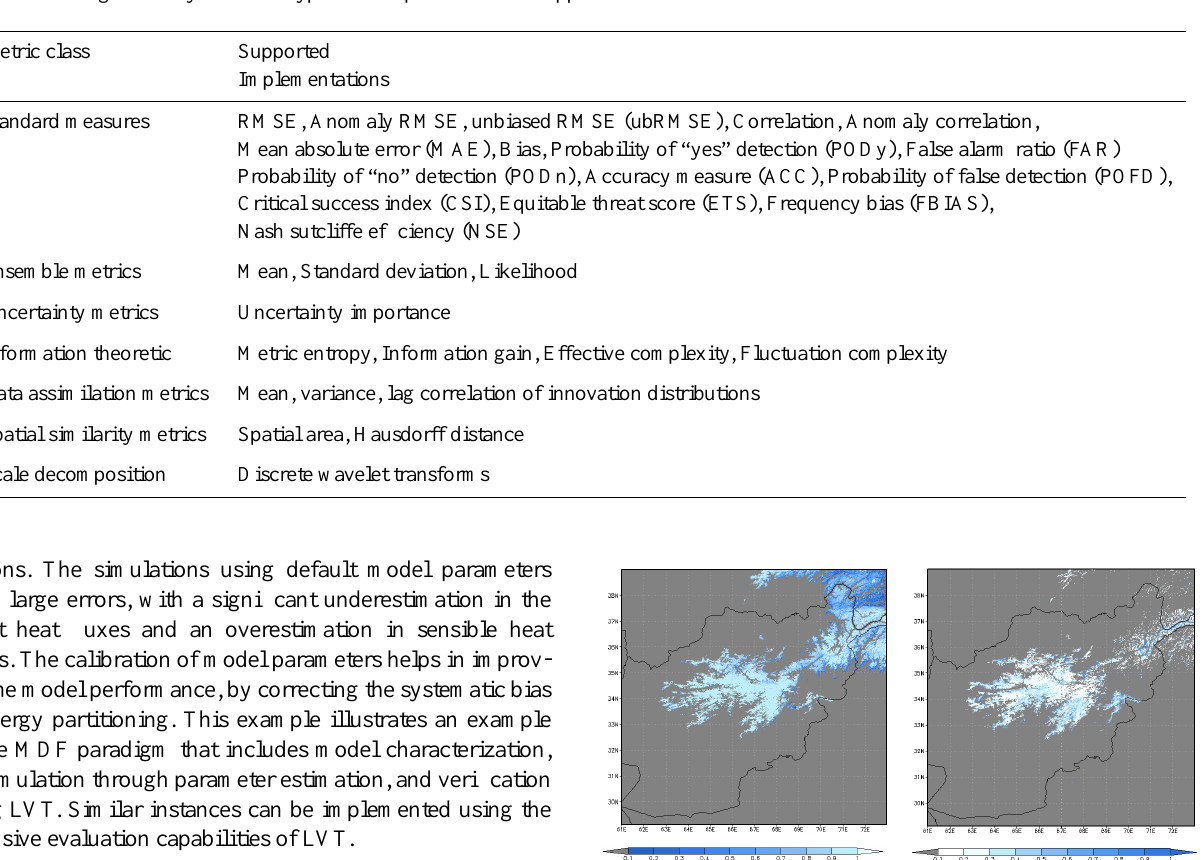
Table 2. The range of analysis metric types and implementations supported in LVT.